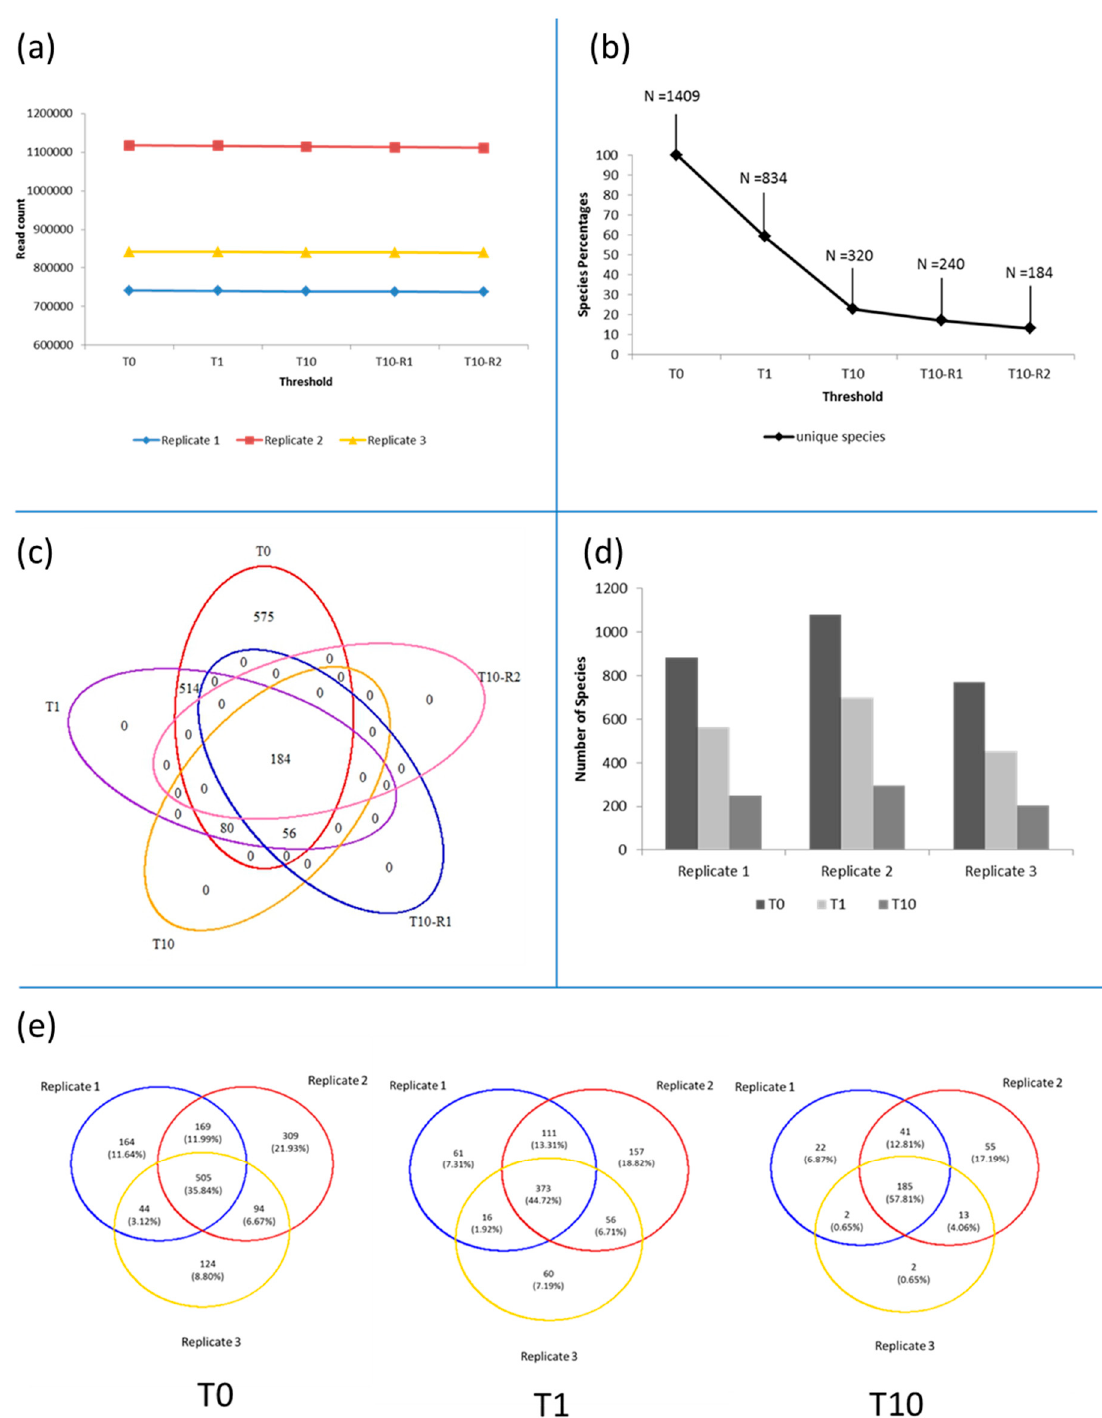
Figure 2. Analyses of the prokaryotic fraction. ( a ) Reduction in number of reads when filters are applied; ( b ) percentage and phylotype count when filter are applied; ( c ) presence–absence analyses at phylotype level before and after application of the filters; ( d ) number of phylotype analyses by replicate; ( e ) presence–absence analyses at phylotype level when filters are applied to each replicate.